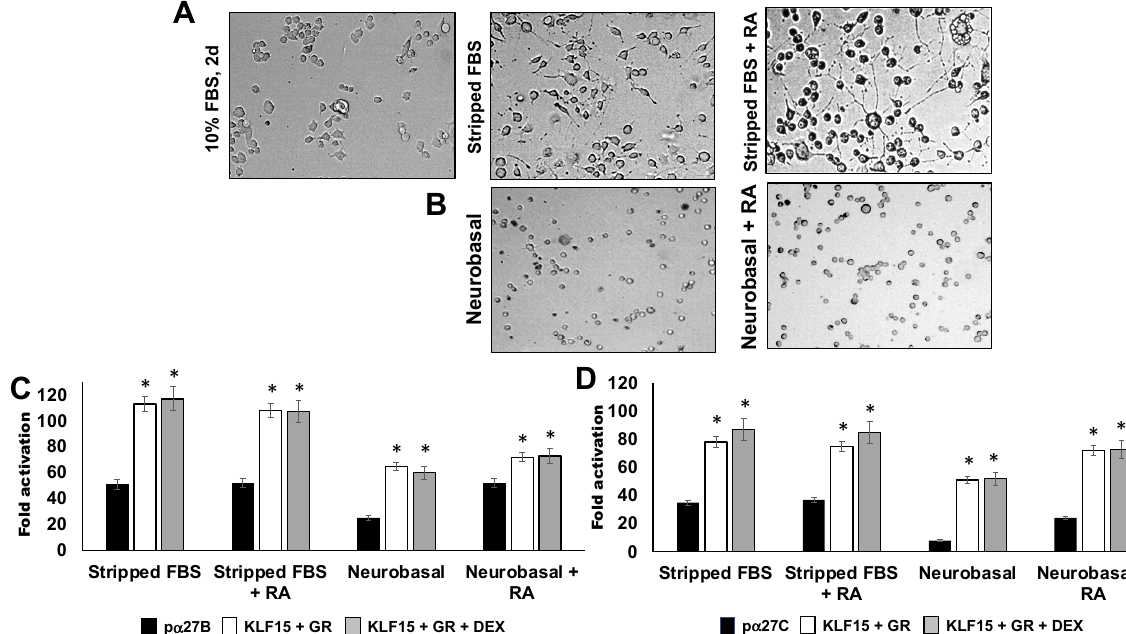
Figure 4. Effect of serum starved neurite formation and Neurobasal™ media on ICP27 enhancer activity. Panel ( A ): Neuro-2A cells were incubated in 10% FBS, 2% stripped FBS, or 2% stripped FBS and RA for 48 h. Neuro-2A cells were seeded at 4 × 10 5 cells per 60 mm dish to allow for optimal neurite formation. Panel ( B ): Neuro-2A cells were incubated in Neurobasal™ medium with B-27™ plus supplement for 48 h. Live cell images were captured 48 h after cells were